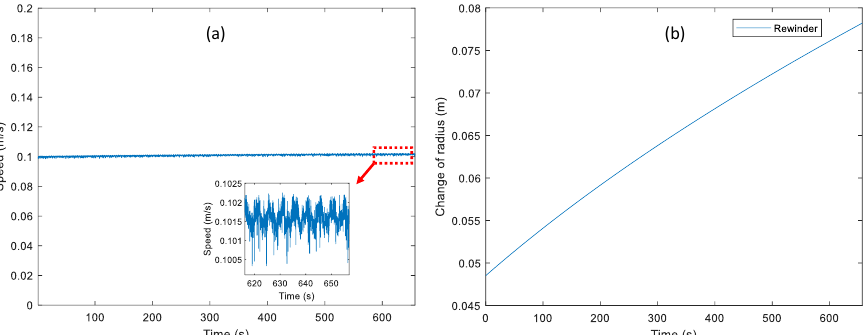
Figure 9. The control performance of the tension at 0.1 m/s of the web speed: ( a ) The tracking error in the tension control loop, ( b ) tension measurement from the loadcell in the unwinder module (tension feedback) and ( c ) control output of the tension control loop.